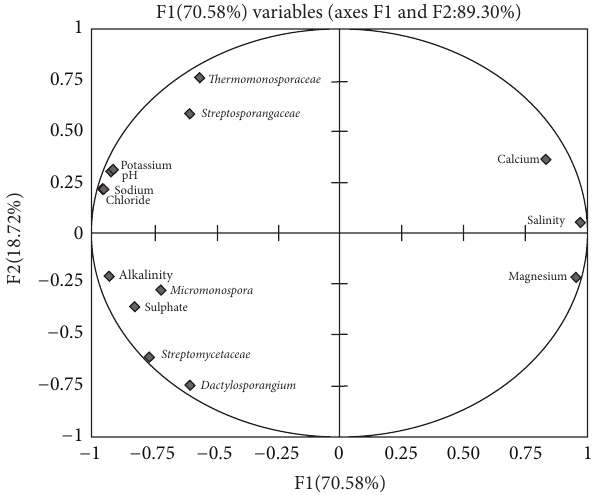
Figure 4: Rarefaction analysis showing sampling evenness. The inset graph shows reference ribotype plot.